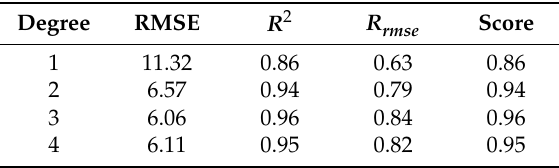
Figure 9. The results of different human detection methods for the same input depth image in our dataset. The input is a typical multiple people scene with occlusion, where five persons in total move in different directions. ( a ) Visualization of processing and results combined with distance transformation and watershed algorithm; ( b ) head central location points clustering based on local maxima search; ( c ) the proposed human detection method based on local pooling and searching; (d) the proposed approach combined with classification refinement removing false positive candidates; Table 4. Head diameter fitting with different degree of polynomials.